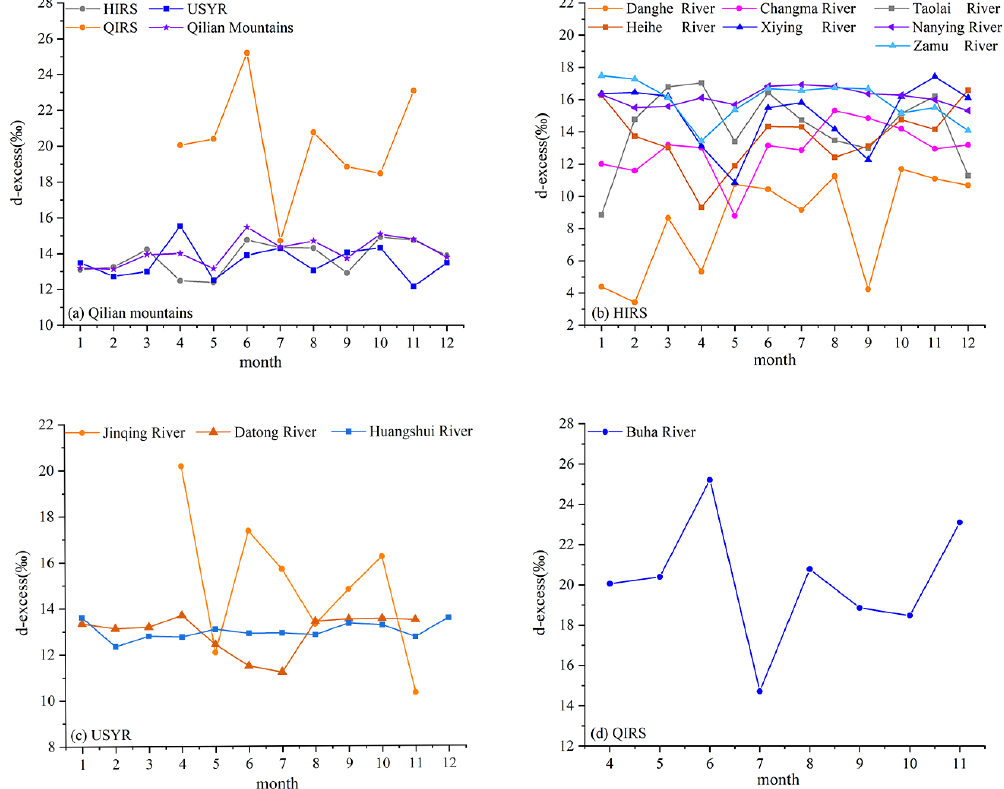
Figure 6. Temporal variation of d-excess in the outlet river in the Qilian